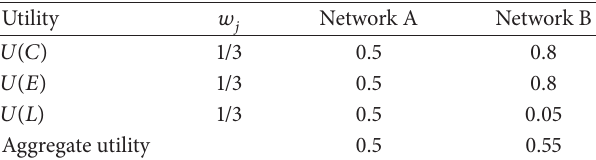
Table 1: Network selection based on